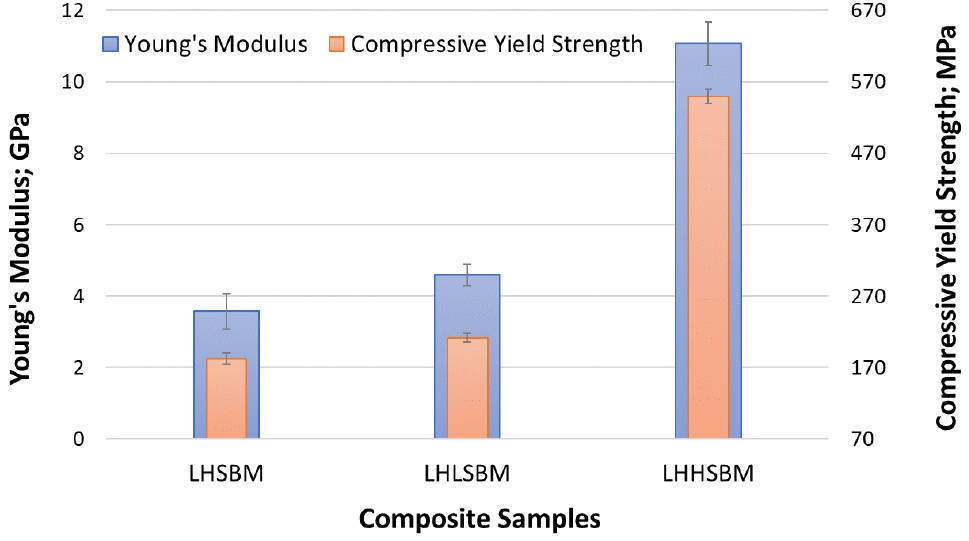
Figure 13. Young’s modulus and yield strength of the Al/SiC composites with different production scenarios. tion